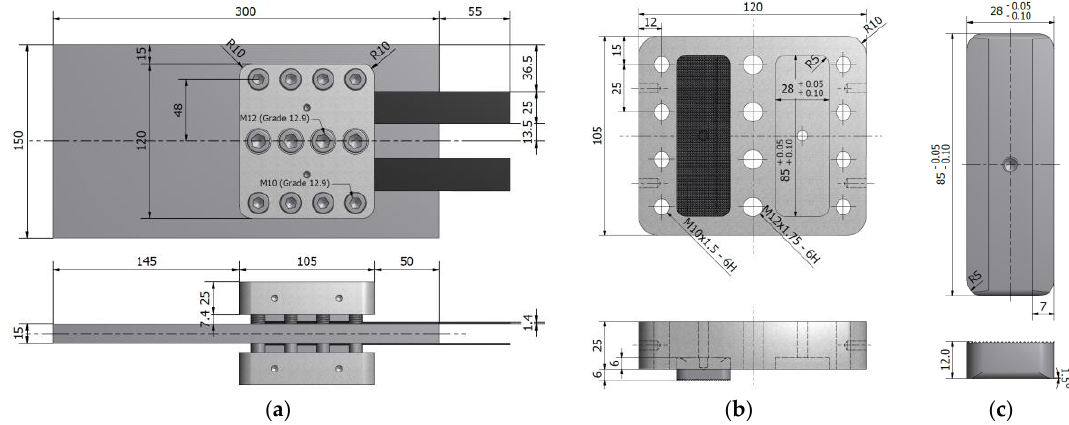
Figure 1. ( a ) Dimensions used in finite element simulation; ( b ) detailed sketch of clamp plate; and, ( c ) detailed sketch of hard plate (all dimensions in mm; ( a – c ) not to same scale).